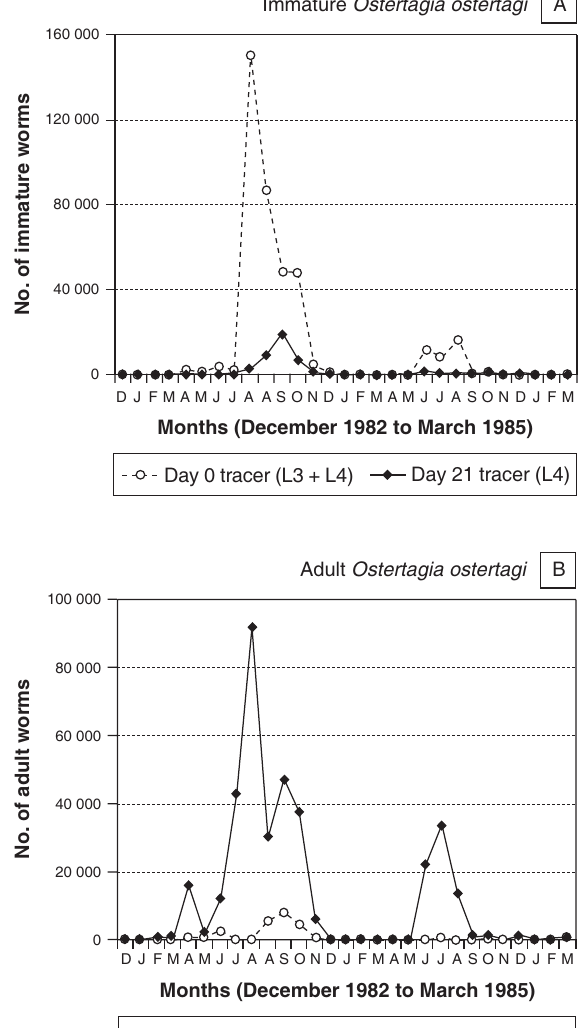
FIG. 8 Seasonality of A) immature and B) adult Ostertagia ostertagi in tracer calves on the farm "Glen Dye", East- ern Cape Province. Two sets of calves were examined during August